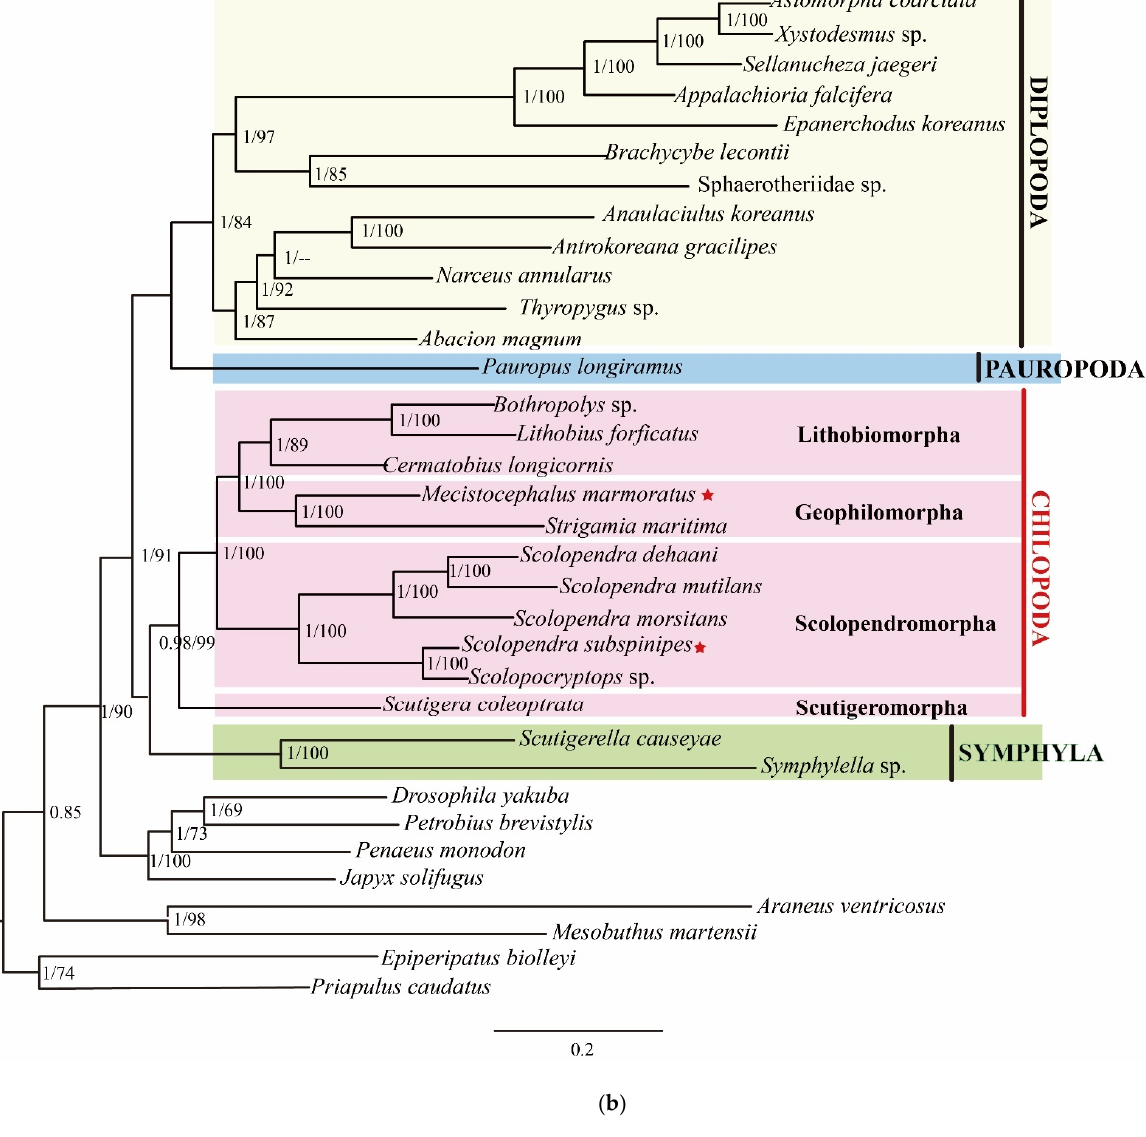
Figure 2. ( a ) Phylogenetic trees of myriapods inferred using Bayesian inference (BI) and the maximum likelihood method (ML) based on the AA matrix. Numbers on the branches indicate the posterior probability (BI) ( left ) and bootstrap values (ML) ( right ). Newly sequenced taxa are indicated using red stars. ( b ) Phylogenetic trees of myriapods inferred using the MrBayes program with the maximum likelihood method based on the PCG12RNA matrix. Numbers on the branches indicate the posterior probability (BI) ( left ) and bootstrap values (ML) ( right ). Newly sequenced taxa are indicated using red stars.